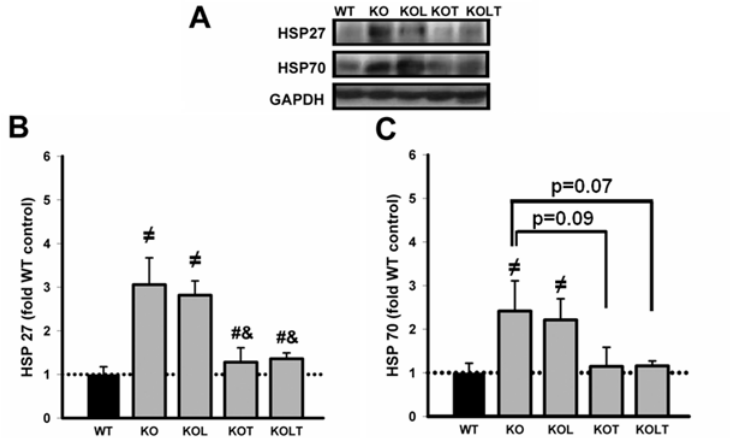
Figure 4. Representative immunoblottings of left ventricular homogenate of HSP27, HSP70 and GAPDH ( A ); HSP27 ( B ) and HSP70 ( C ) protein levels in control wild type (WT), α 2A / α 2C ARKO mice placebo (KO) or leucine (KOL), and exercise trained (KOT) or exercise trained and leucine-supplemented (KOLT). Data are presented as mean ± SE. n = 7–9/group. ≠ p < 0.05 vs. WT; # p < 0.05 vs. KO; & p < 0.05 vs. KOL.